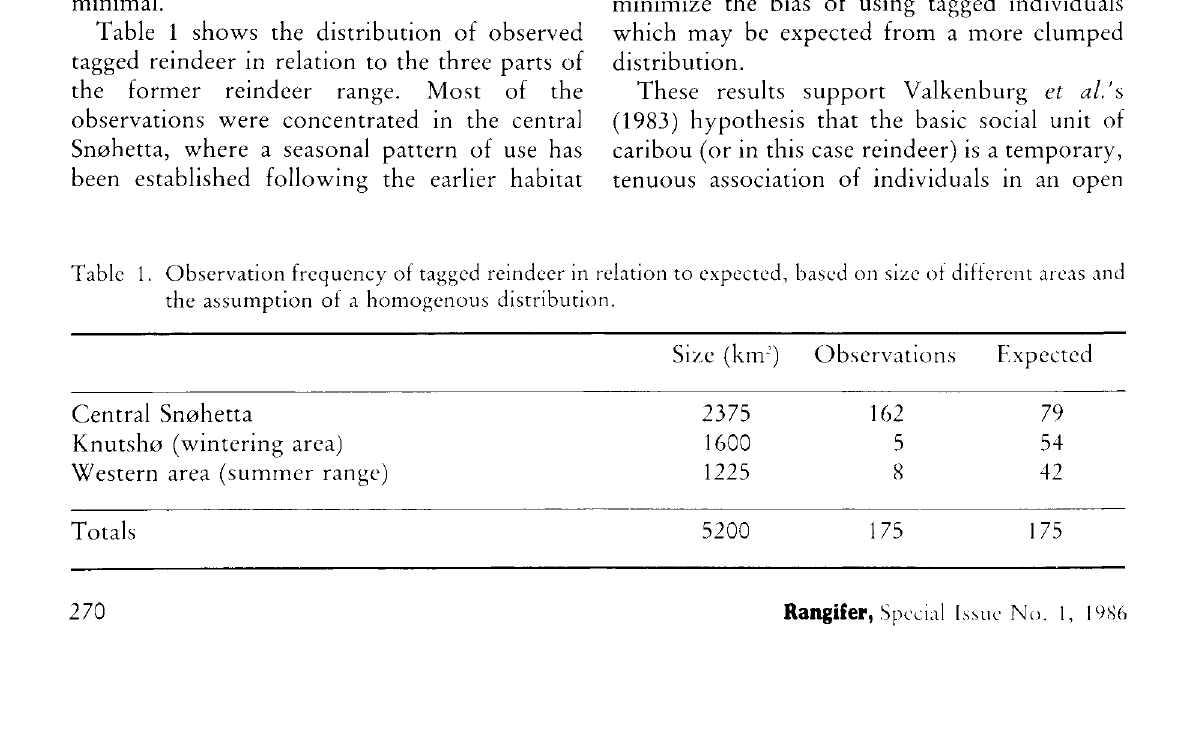
Fig. 2. The percentage of the Snøhetta herd which crossed the transportation corridor (Euro pean highway No. 6, and railroad track) across Dovrefjell in relation to percentage normal snow accumulation (data from Norwegian Meteorological Records).